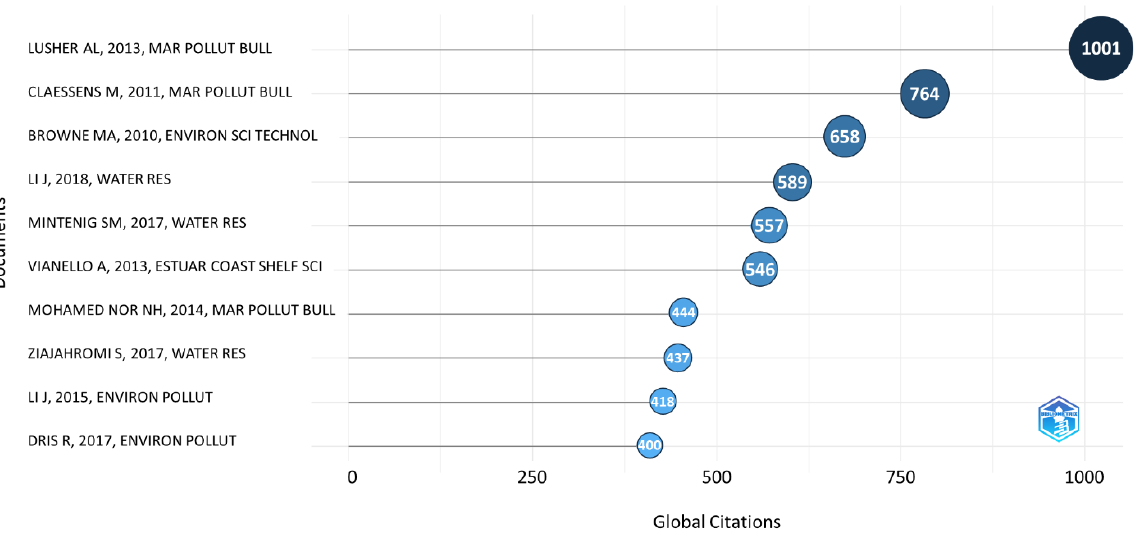
Figure 5. Top 10 most globally cited documents with number of citations for FTIR-related literature [40 – 49]. The figure was generated using the open-source tool Biblioshiny for Bibliometrix (Aria and Cuccurullo